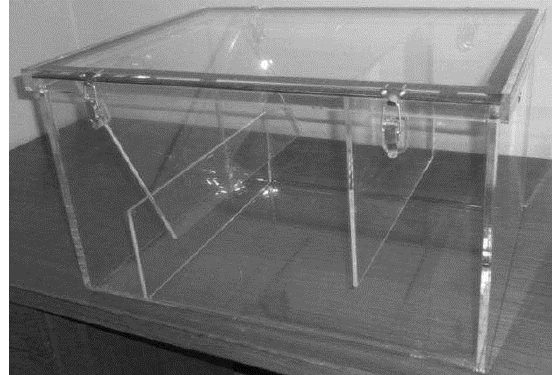
Figure 3. Prototype test boxes.